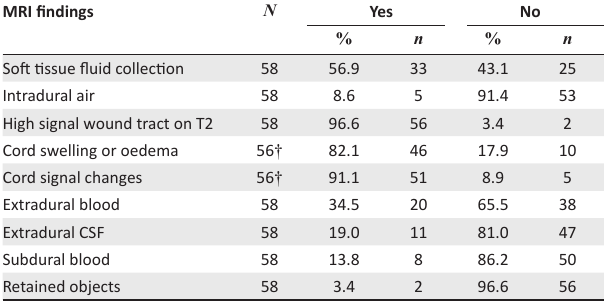
TABLE 1: Magnetic resonance imaging findings in all stab